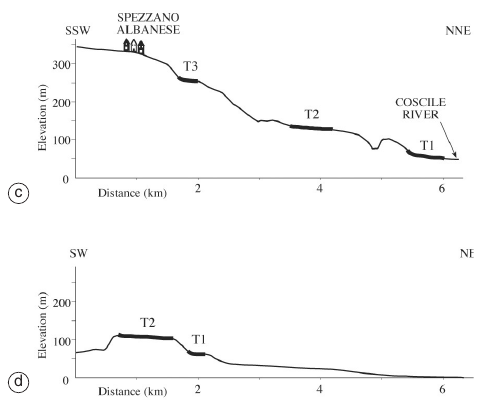
Fig. 5a-d. Topographic profiles along four sections representative of the area (see fig. 2 for location of the sections). Thicker lines mark the different terrace surfaces. Profiles ‘a’and ‘b’report the stratigrafies of two boreholes drilled along the direction of the sec- tions; profile ‘a’ also shows the location of the sam- ples used for the